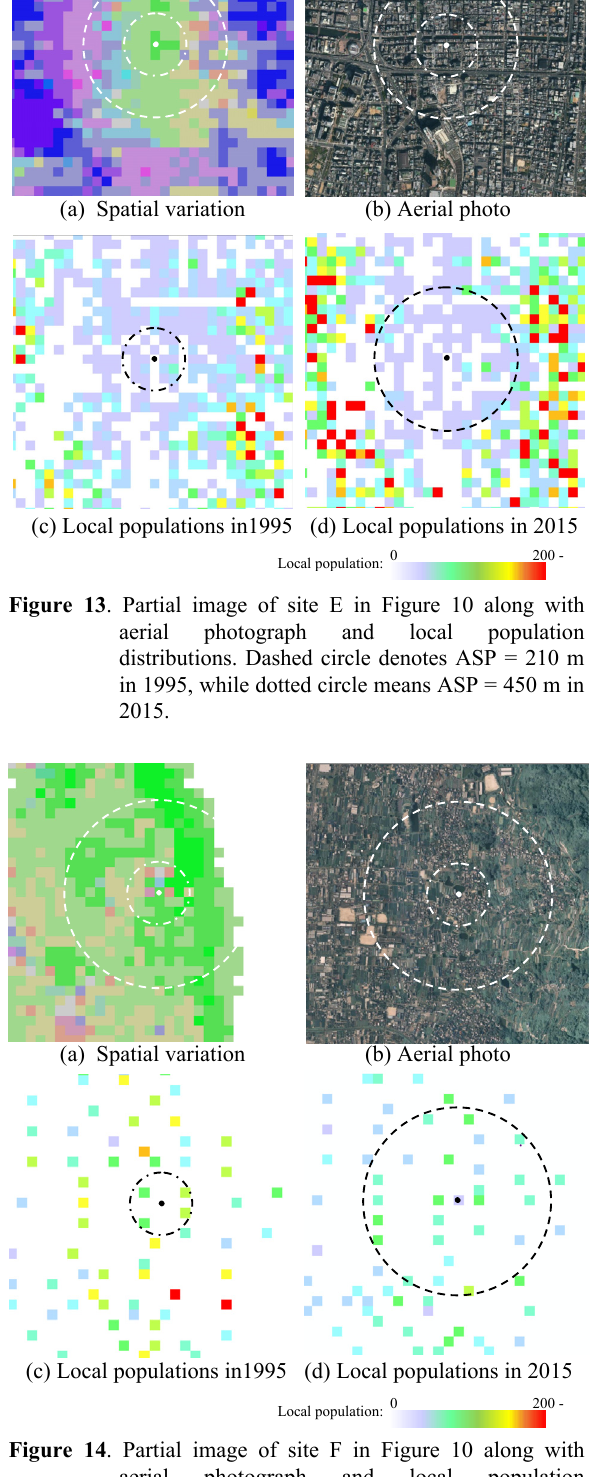
Figure 12 . Partial image of site D in Figure 10 along with aerial photograph and local population distributions. Dashed circle denotes ASP (= 450 m) in 1995. In 2015, circle does not appear (ASP 0 ).